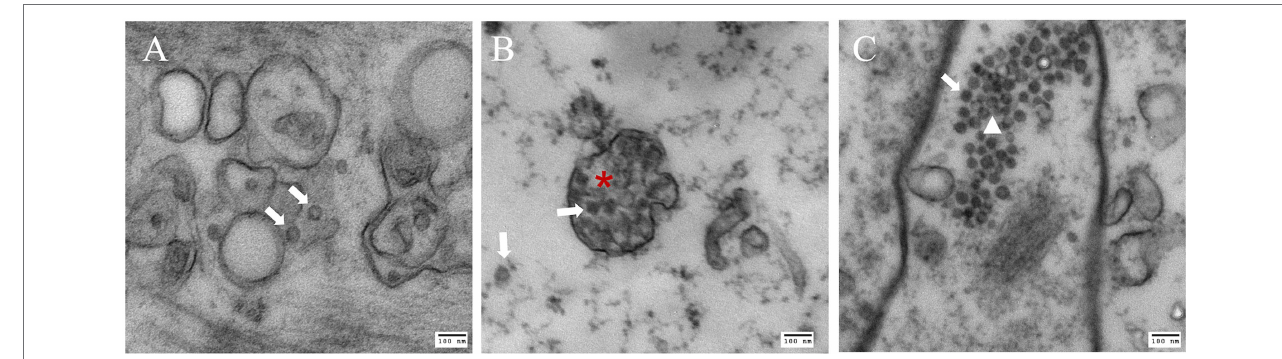
FIGURE 6 | Electron microscopy images of putative CsTLV1 and CsTLV2 viral particles in muscle, gill, and hepatopancreas tissues of Callinectes sapidus . (A) muscle; (B) gills; and (C) hepatopancreas. White arrow: virions; Red star: putative “viroplasm” in gill. White triangle: dense arrangement of virions in hepatopancreas. Scar bar, 100